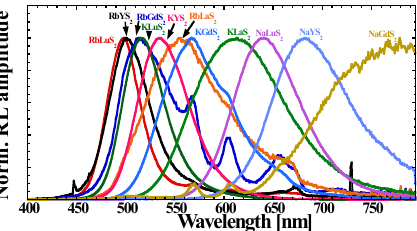
Figure 3. Room temperature radioluminescence (RT RL) spectra (40 kV, 15 mA) of ALnS 2 :Eu; data of KLuS 2 :Eu after [27].